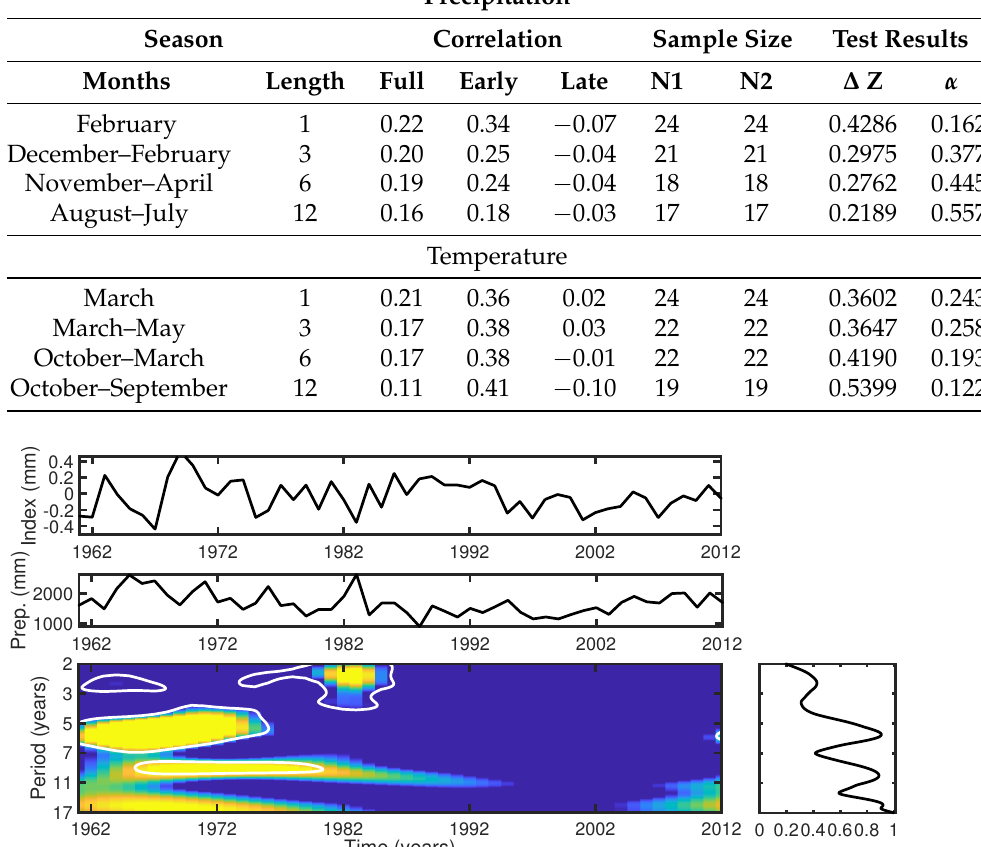
Figure 8. Cross-wavelets between the average growth rings’ dendrochronological series and February precipitation time-series with the global spectrum (bottom right panel) and the confidence level of 95% (white